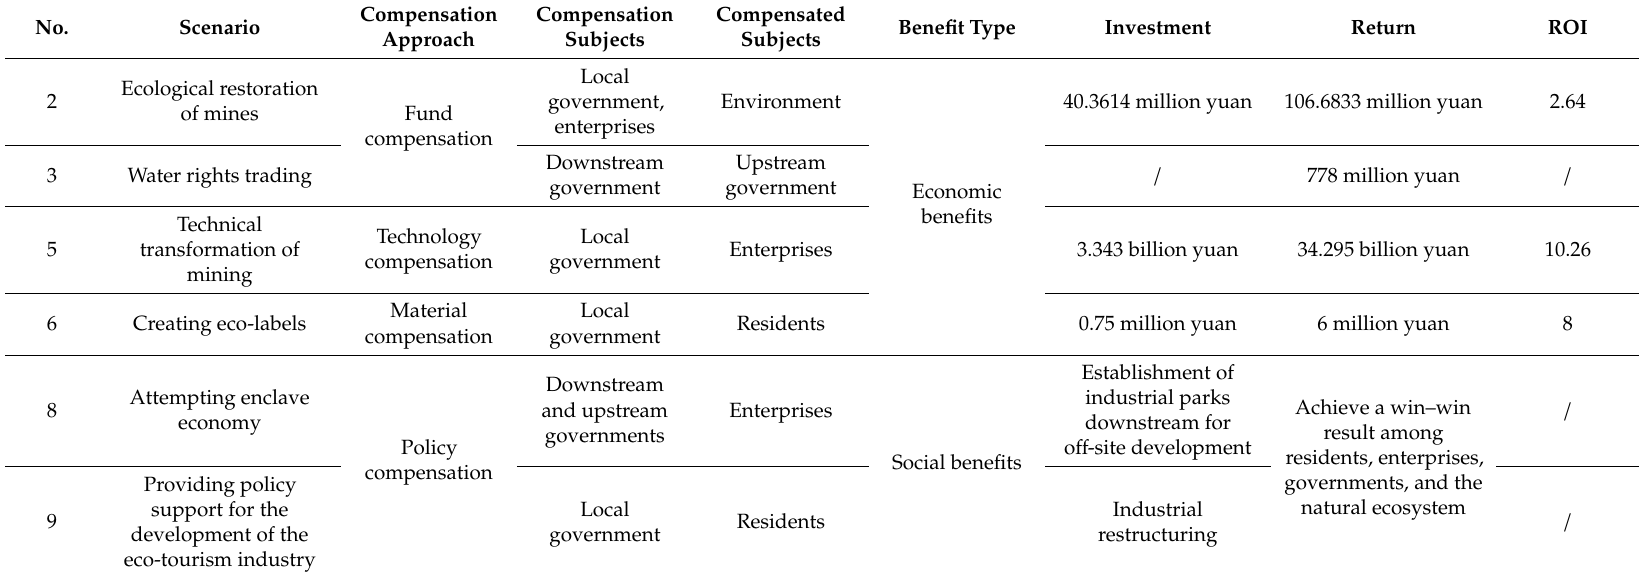
Table 3. Comprehensive analysis of the ecological compensation